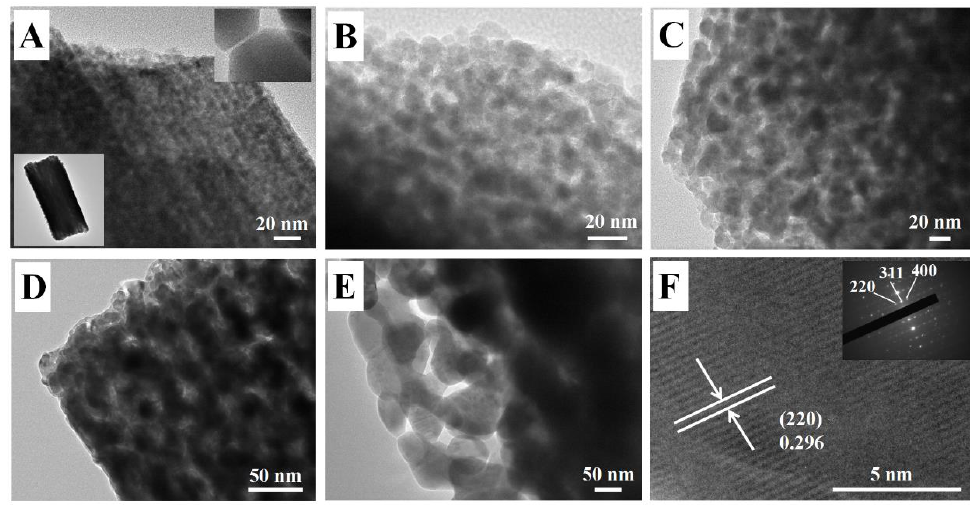
Figure 3. Typical images of ( A ) CF300; ( B ) CF400; ( C ) CF500; ( D ) CF600; and ( E ); CF700 ( F ); HRTEM image of CF300, and the inset in ( F ) is the SAED pattern.